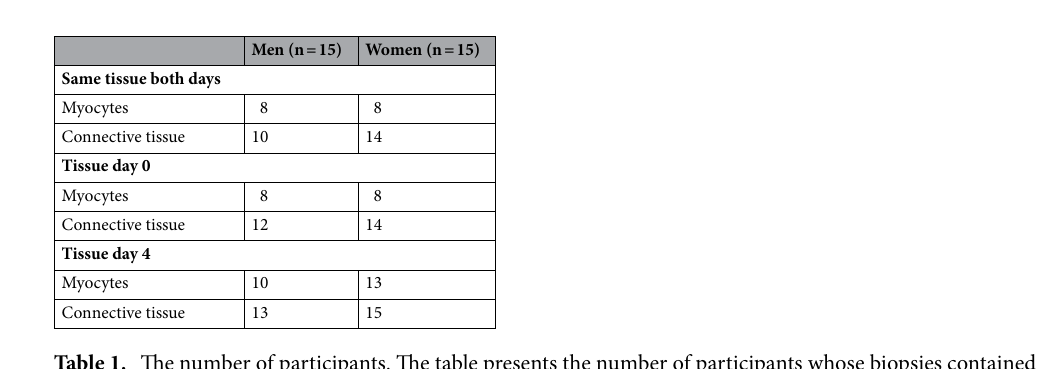
Table 1. The number of participants. The table presents the number of participants whose biopsies contained myocytes and connective tissue on both days as well as the number of participants whose biopsies contained myocytes and connective tissue on day 0 and day